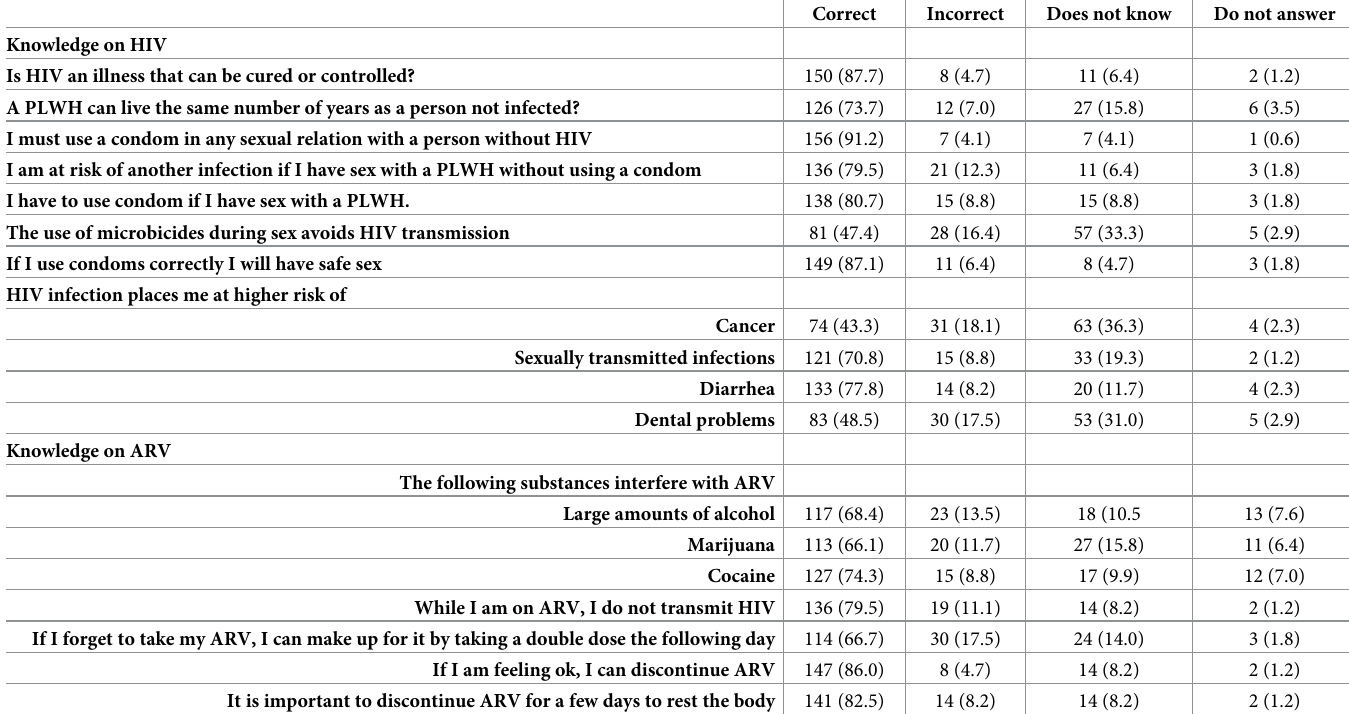
Table 1. Knowledge on HIV and ARV, among people living with HIV in a referral center in Lima, Peru, 2016–2017 (N = 171).